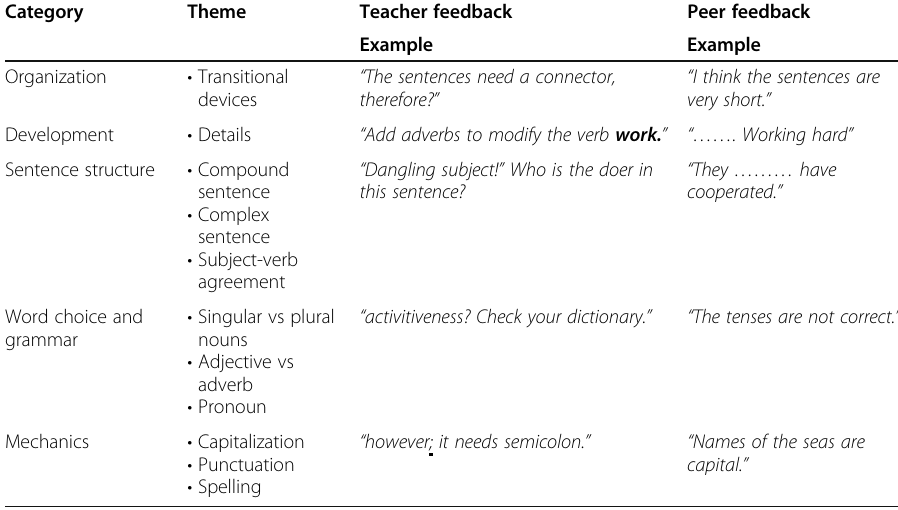
Table 3 The analytical scheme for classifying TA and PA on descriptive writing tasks Category Theme Teacher feedback Peer feedback